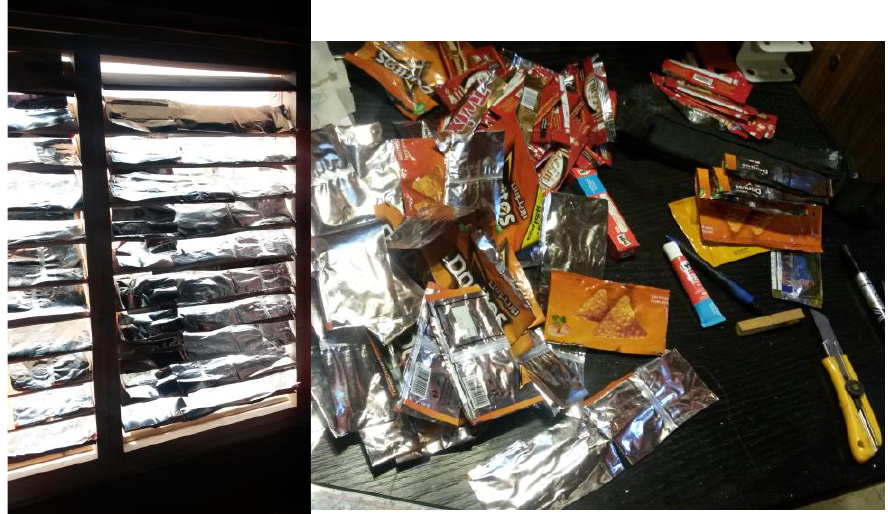
Figure 11. The figure showcases photos of the MS installation after the application of the reflective snack